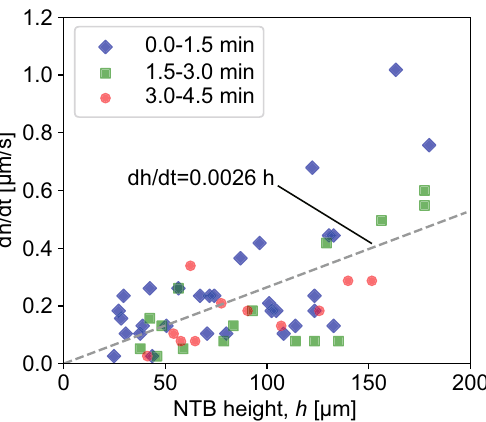
Figure 11. Growth rate of the NTB height as a function of the NTB height measured from SEM micrographs. The growth rate was derived from the variation in height before and after repeated 1.5 min of He irradiation under co-deposition